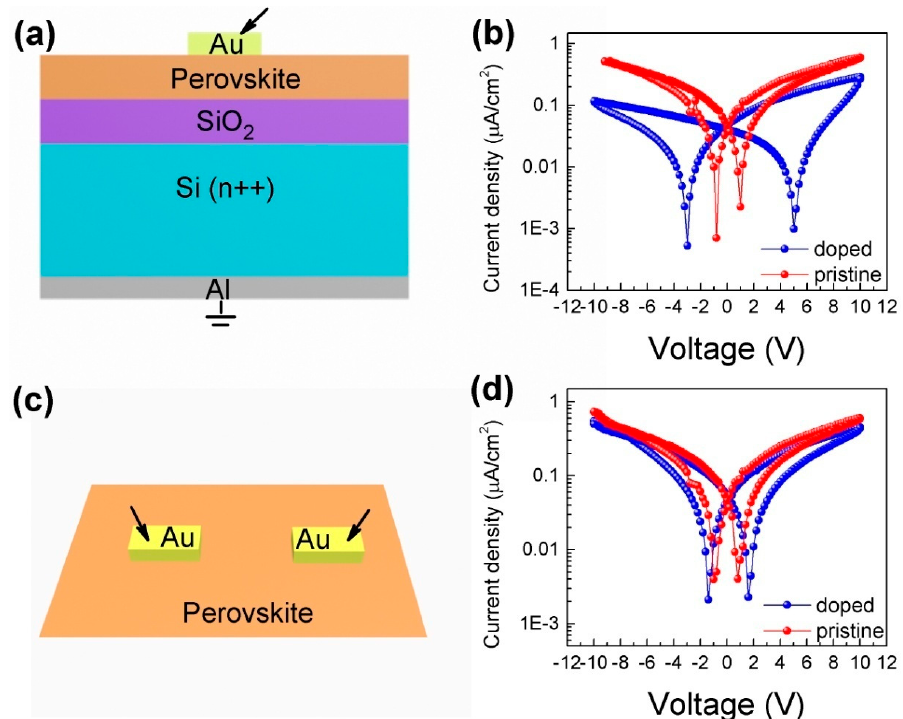
Figure 2. I-V characteristics of iodine-doped perovskite and pristine perovskite based on different device structures in the dark. ( a ) Al/Si/SiO 2 /perovskite/Au vertical structure. ( b ) I-V hysteresis curves of iodine-doped perovskite and pristine perovskite based on the Al/Si/SiO 2 /perovskite/Au vertical structure. ( c ) Au/perovskite/Au lateral structure. ( d ) I-V hysteresis curves of iodine-doped perovskite and pristine perovskite based on the Au/perovskite/Au lateral structure.